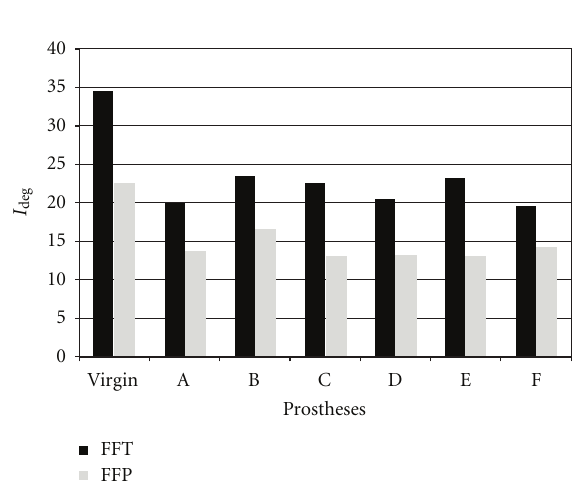
Figure 15: Variation of the diethylene glycol groups. I DEG is the integral peaks values of the diethylene glycol groups.